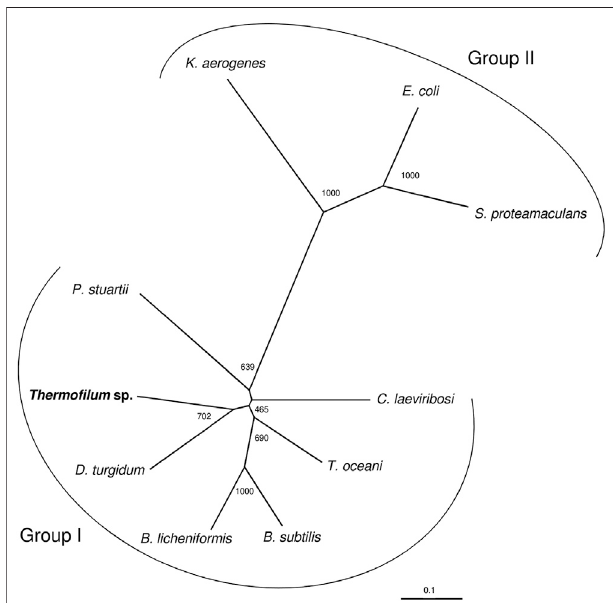
FIGURE 7 | The phylogenetic relationship of TsLI with respect to other characterised bacterial lyxose isomerases from group I and group II type enzymes. The tree is based upon a multiple sequence alignment that was generatedwithClustalO(Sieverset al.,2011).Numbersat thenodes are bootstrapping values according to neighbour joining. UniProt accession numbers are as follows: C. laevoribosii LI (GenBank accession no. ABI93960.1), P. stuartii LI (EDU58657), B. licheniformis LI (AAU22106.1), B. subtilis LI (AIY91703), D. turgidum LI (YP_002352606.1), and T. oceani LI